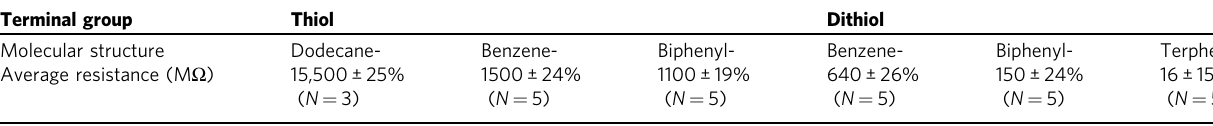
Table 1 DC resistance of nanoparticles fi lms prepared using various molecules. Terminal group